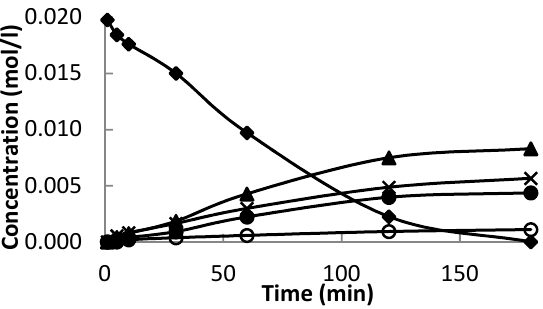
Figure 6. Kinetics in the α -pinene oxide isomerization over 32 wt % Ce–Si–MCM-41 at 140 °C, using dimethylacetamide as a solvent. Symbols: α -pinene oxide ( ♦ ), trans -carveol ( ▲ ), campholenic aldehyde (X), fencholenic aldehyde (o) and 2-methyl-5-(propan-2- ylidene)cyclohex-2-enol ( ●